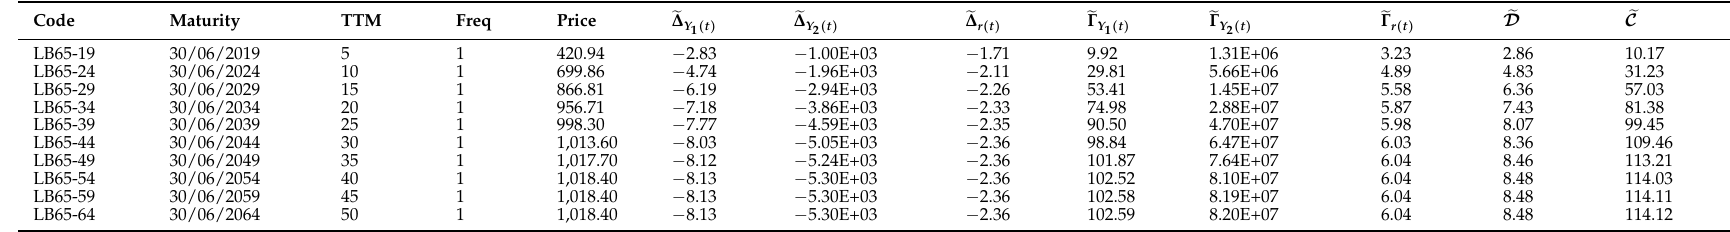
Table 11. These longevity bonds are hypothetical bonds with maturities at 5 year intervals up to a maximum of 50 years. They are based on a cohort aged 65 at issue. Fisher-Weil durations at the longer maturities do not vary much with a maximum of 8.48 years. The interest rate deltas also show very little variation with maturity. The deltas for Y 1 ( t ) in the mortality model are of a similar magnitude to the Fisher-Weil durations. The gammas for Y 1 ( t ) are of a similar magnitude to the convexity. The deltas for the Y 2 ( t ) are larger and reflect the impact of